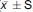
Effect of short-term SD on the BrdU-positive cells in the rat DG area 14 days after GCIR.Representative photomicrographs of BrdU-positive cells (brown) in the DG area shown at 200x magnification (A). Histogram representing the percentage of BrdU-positive cells in proportion of the total number of cells in the DG area of the rat hippocampus (x¯±S, n = 4) (B). * P<0.01 compared with the S group; # P<0.05 compared with the GCIR group.